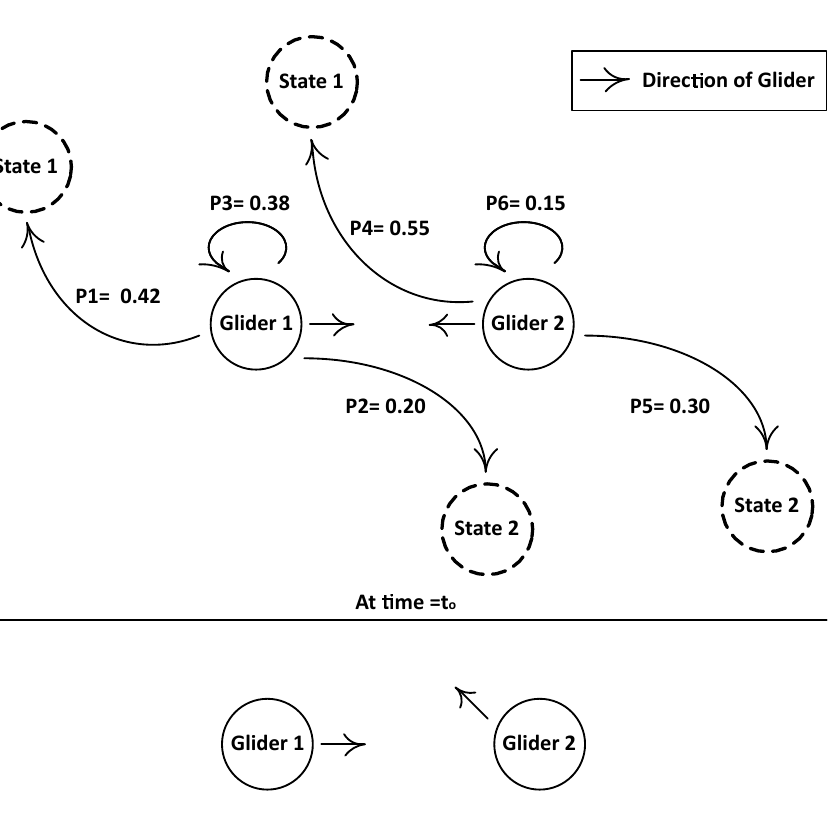
Figure 3. Neighboring gliders are too close.